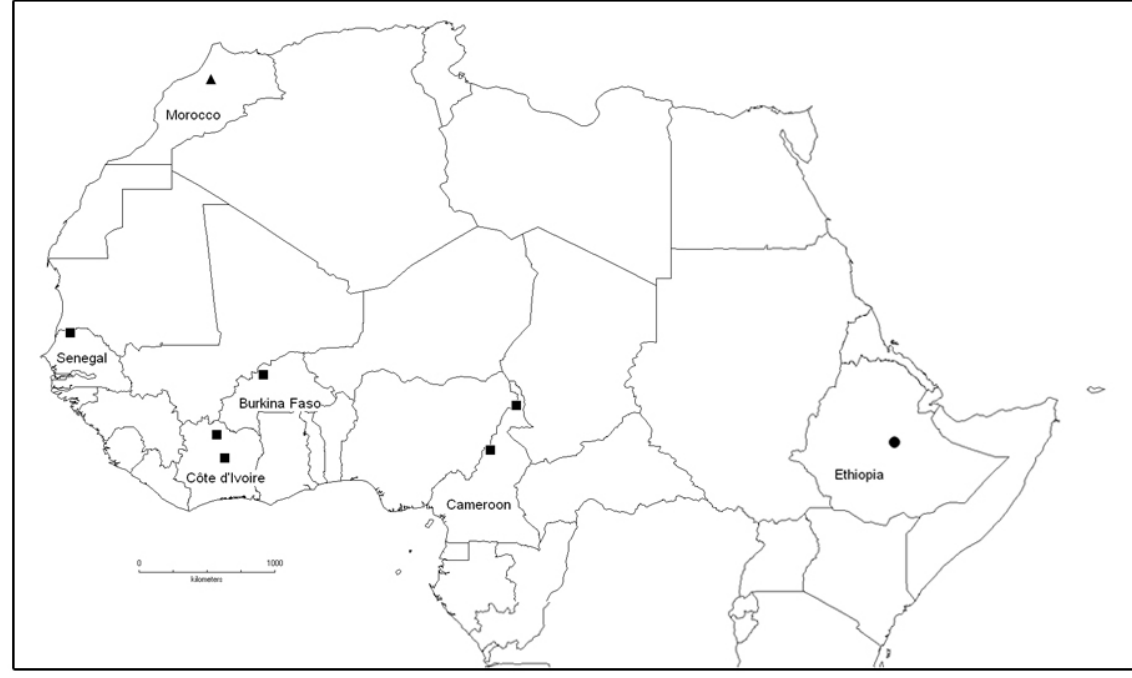
Fig. 13. Distribution map of A. crateriferum sp. nov. (●), A. sahelense sp. nov. ( ■ ) and A. quercicola sp. nov. ( ▲